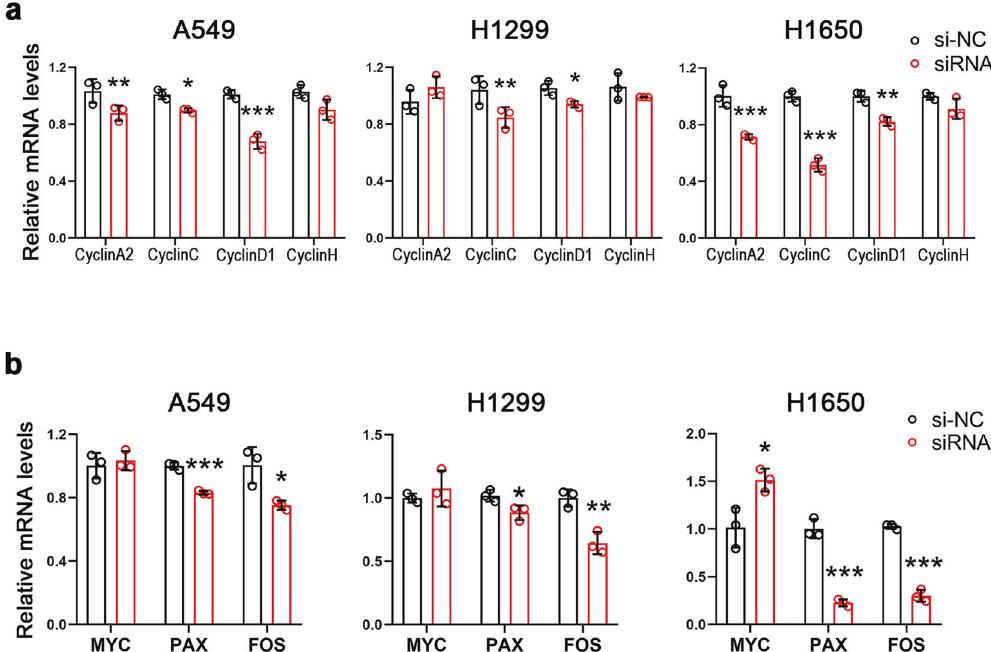
Fig. 4 Knockdown of Rassf9 decreases the expression of cyclins and oncogenes. a Knockdown of Rassf9 inhibits the mRNA levels of cyclins. b Effects of Rassf9 knockdown on the expression of c-Myc , Pax , and Fos . A549, H1299, and H1650 cells were transfected with Rassf9 siRNA. Forty-eight hours post-transfection, total RNA was extracted for gene expression analysis by qRT-PCR and GAPDH was used as a house- keeping gene. Data are presented as means ± SD (error bars). * P < 0.05, ** P < 0.01, and *** P < 0.001. Student ’ s t